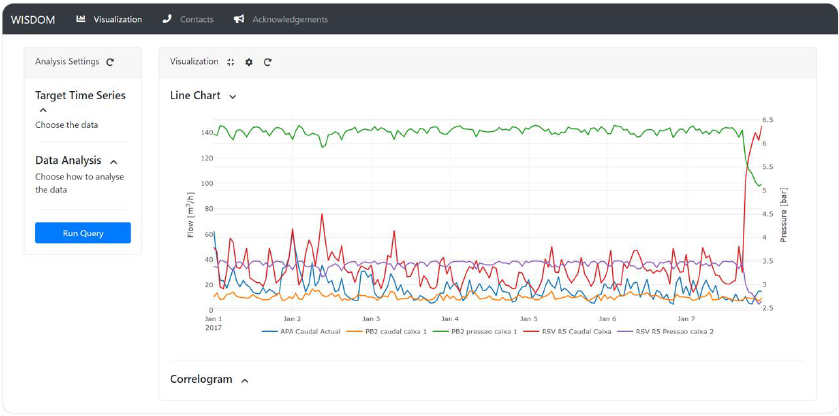
Figure 3. Decision support tool: series visualization with sensor and temporal selection